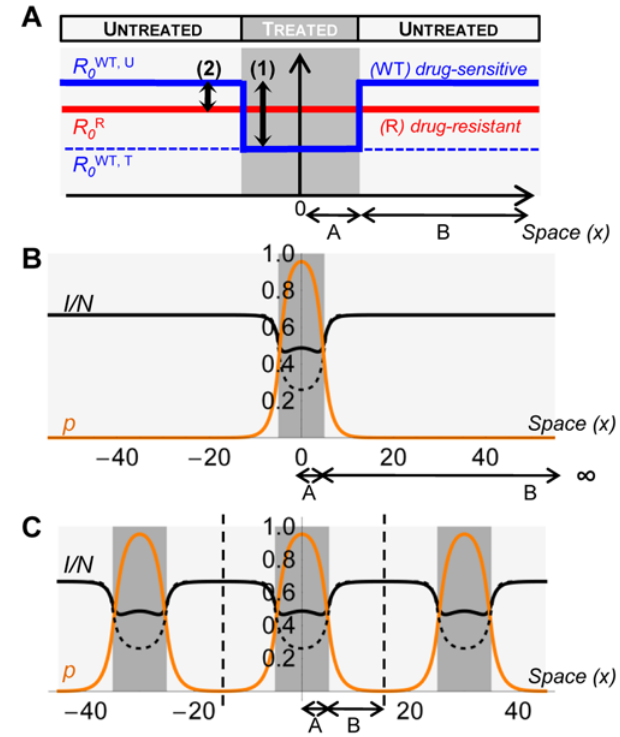
Figure 1. Effects of spatial heterogeneity on the parasites. The treated area is represented with a dark gray filling. Subfigure (a) shows the effects of treatment on the basic reproductive ratios R 0 . Blue stands for drug-sensitive and red for drug-resistant. The arrow (1) shows the effect of treatment on the drug-sensitive parasites, and (2) the cost of drug-resistance. Subfigures (b) and (c) show numerical resolutions of the direct transmission model. In (b), the width of the untreated area, B , is infinite; in (c), B is finite. In (b) and (c), the full black curve is the prevalence of the disease at equilibrium, I = N , and the orange curve is the cline of frequency p of individuals infected by the drug- resistant strain, among all infected individuals. The dashed black curve represents the equilibrium prevalence in the absence drug- ~ 0 : 03 , b ~ 0 : 025 , resistant parasites. Parameters: N ~ 100 , b U R WT ~ 0 : 02 , c U ~ 1 , c ~ 1 : 25 , c T ~ 1 : 5 . b T R WT WT WT